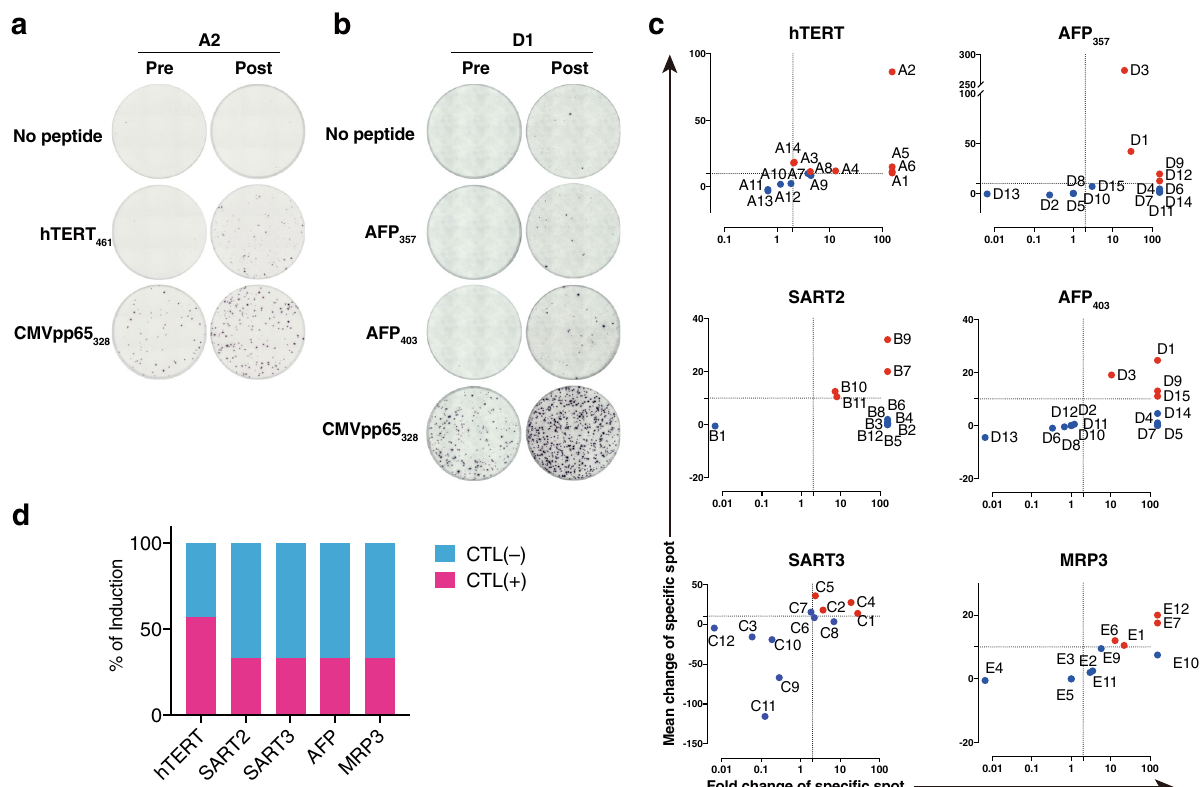
Fig. 1 Peptide-speci fi c immune responses induced by peptide vaccine treatments. PBMCs were collected before and at 3 – 6 months after vaccination